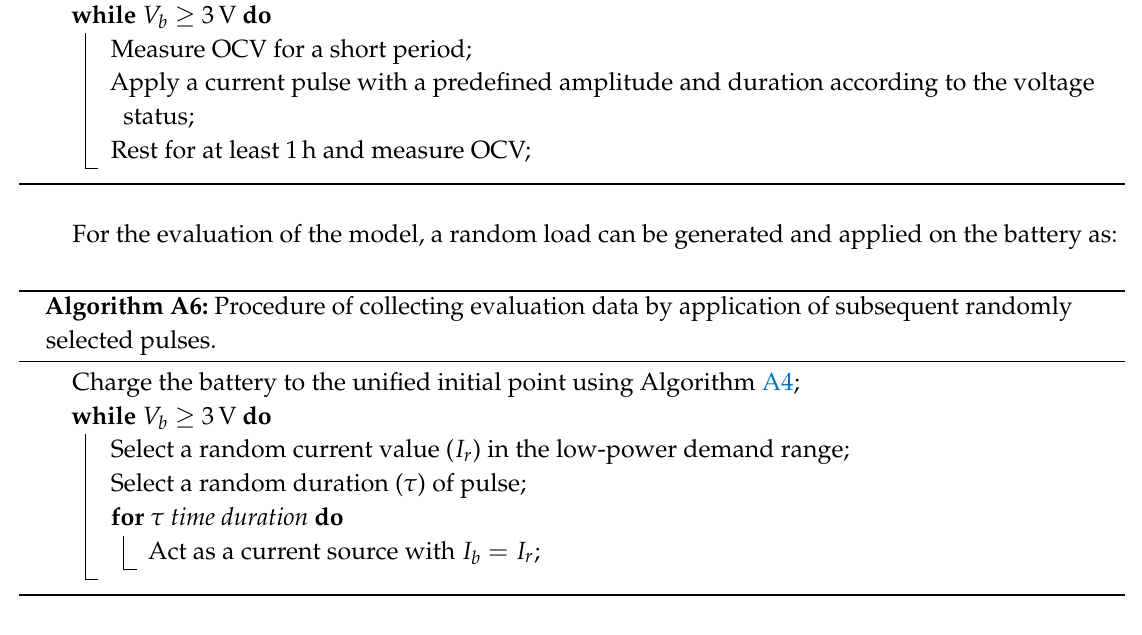
Algorithm A5: A process for identification of the SoC-V e relation in the discrete form. Charge the battery to the unified initial point using Algorithm A4;